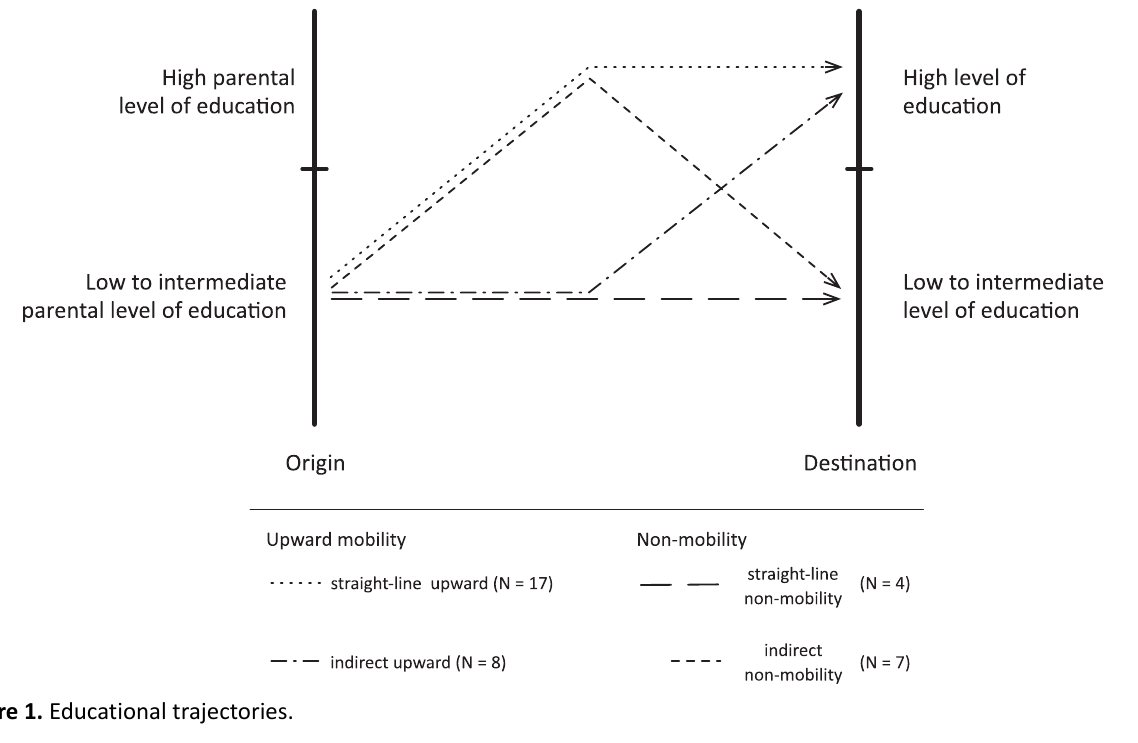
Figure 1. Educational